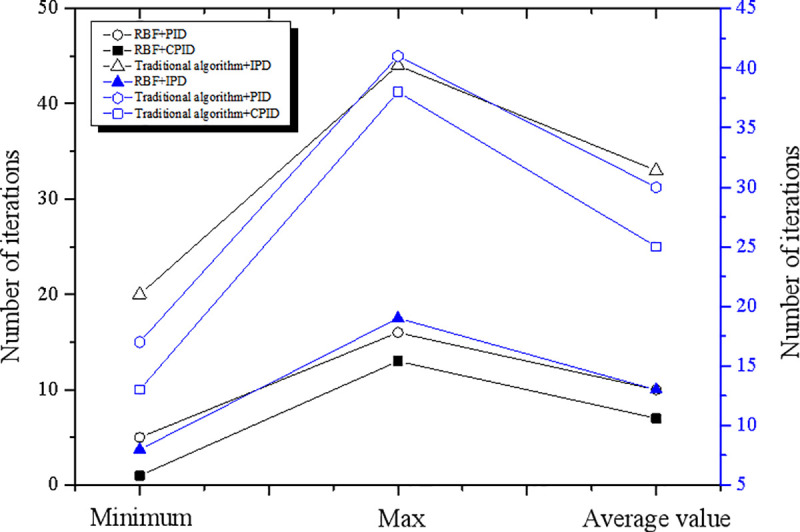
Comparison on optimization results of controller with the RBF neural network and traditional algorithms.